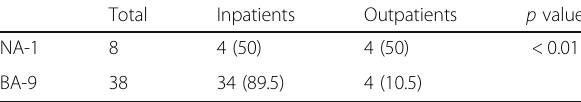
Table 2 Distribution of respiratory syncytial virus